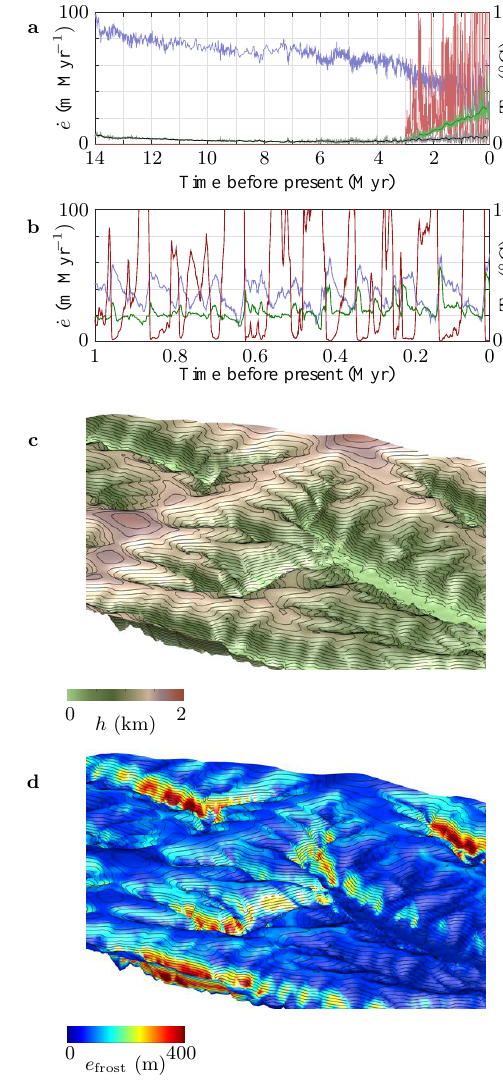
Figure 13. Panel (a) : long-term erosion outcomes for experiment (no. 3) shown in Fig. 12, which combines subglacial and periglacial erosion (over the final 3Myr of the total 14Myr simulation). The red curve is subglacial erosion rate, and the green curve is the periglacial erosion rate. The black curve shows the periglacial ero- sion rate from the experiment without glaciers (same as black curve in Fig. 11a). The blue curve is sea-level MAT. The difference be- tween the black and green curve highlights the effect of subglacial erosion on the periglacial erosion rate, which is significantly accel- erated by the glacial landscape modifications. Panel (b) : details of erosion rates during the final 1Myr, showing subglacial erosion rate (red line), periglacial erosion rate (green line), and sea-level MAT (blue line). Panel (c) : final stage of the landscape (same as Fig. 12d) with detail magnified at location shown by the black rectangle in Fig. 10a. Panel (d) : total periglacial erosion. Note that the glacially steepened valley sides are most effectively attacked by frost crack-